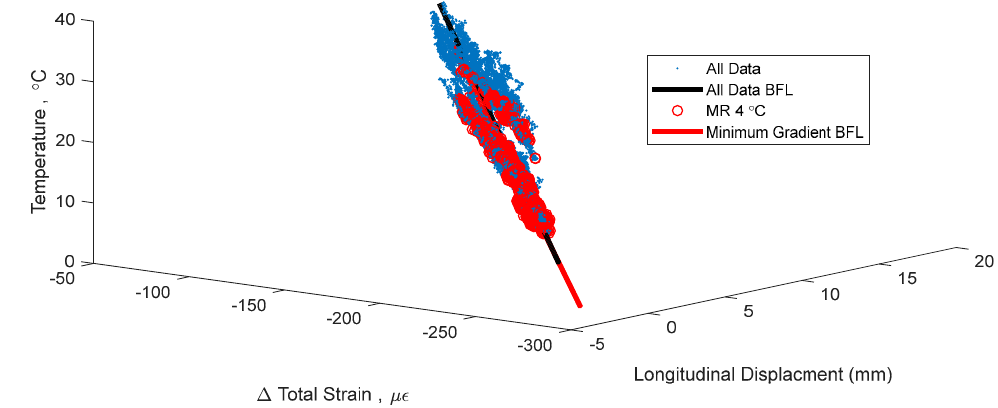
Figure 10. 3D signature example with best fit line (BFL) for time points with minimal thermal gradient, identified using MR method.